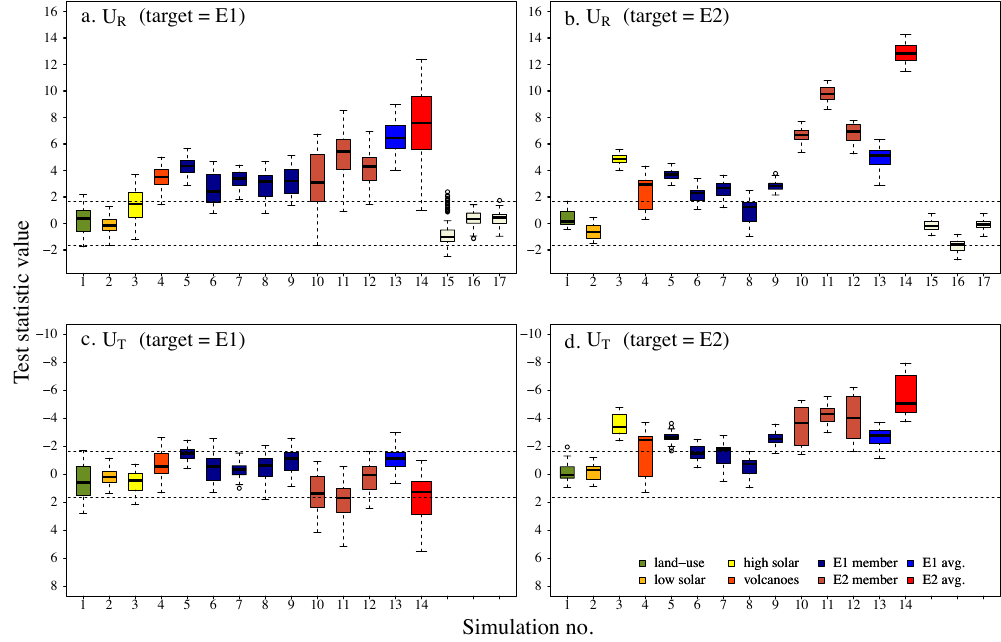
Fig. 5. As Fig. 3, but using the local proxy locations from Juckes et al. (2007).